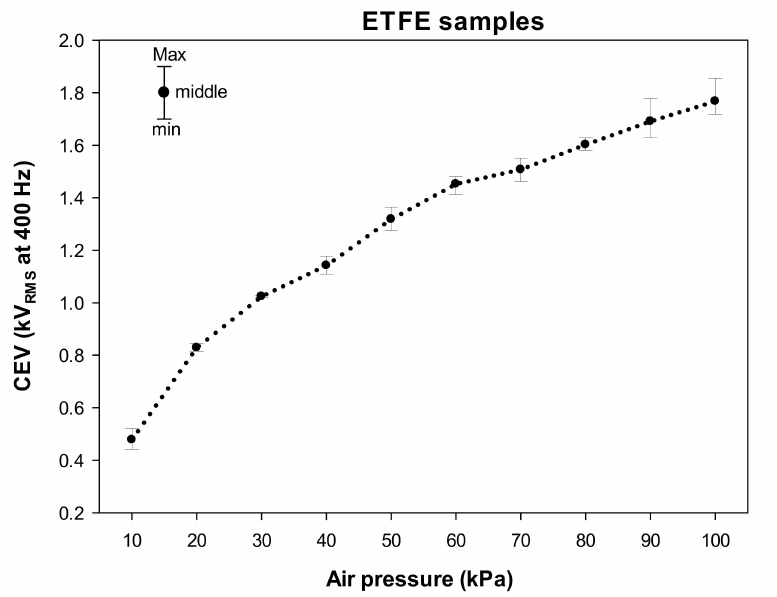
Figure 5. CEV values measured at 400 Hz of the analyzed ETFE samples (three replicas each) in the 10–100 kPa interval covering the aeronautic pressure